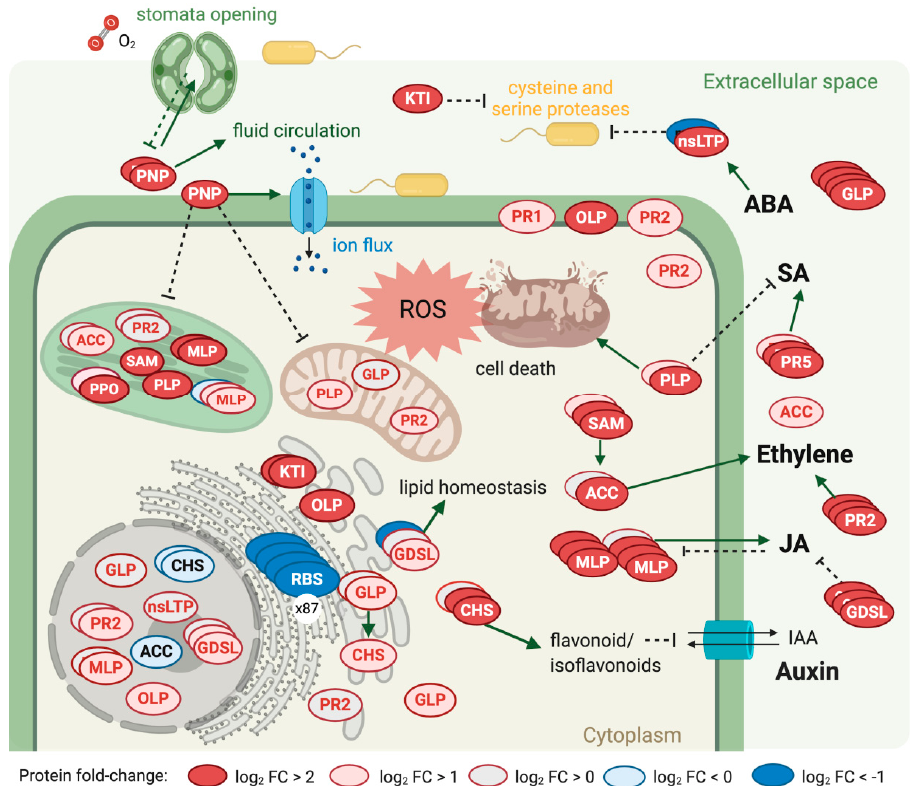
Figure 6. Walnut bacterial blight plant response following Xaj 417 infection. Copies of proteins from the same family detected in proteomics are represented. ACC: 1-aminocyclopropane-1-carboxylate oxidase, CHS: chalcone synthase, GDSL: GDSL lipase/esterases, GLP: germin-like proteins, KTI: Kunitz trypsin inhibitor, MLP: major latex proteins, nsLTP: plant nonspecific lipid-transfer protein, OLP: osmotin-like protein (PR5-like), PLP: patatin-like protein, PNP: plant natriuretic peptides, PR1: pathogenesis-related 1, PR2: glucan endo-1,3-beta-glucosidase, PR5: pathogenesis-related 5, SAM: S-adenosylmethionine synthase, JA: jasmonic acid, SA: salicylic acid, and ROS: reactive oxygen species. Created with BioRender.com.